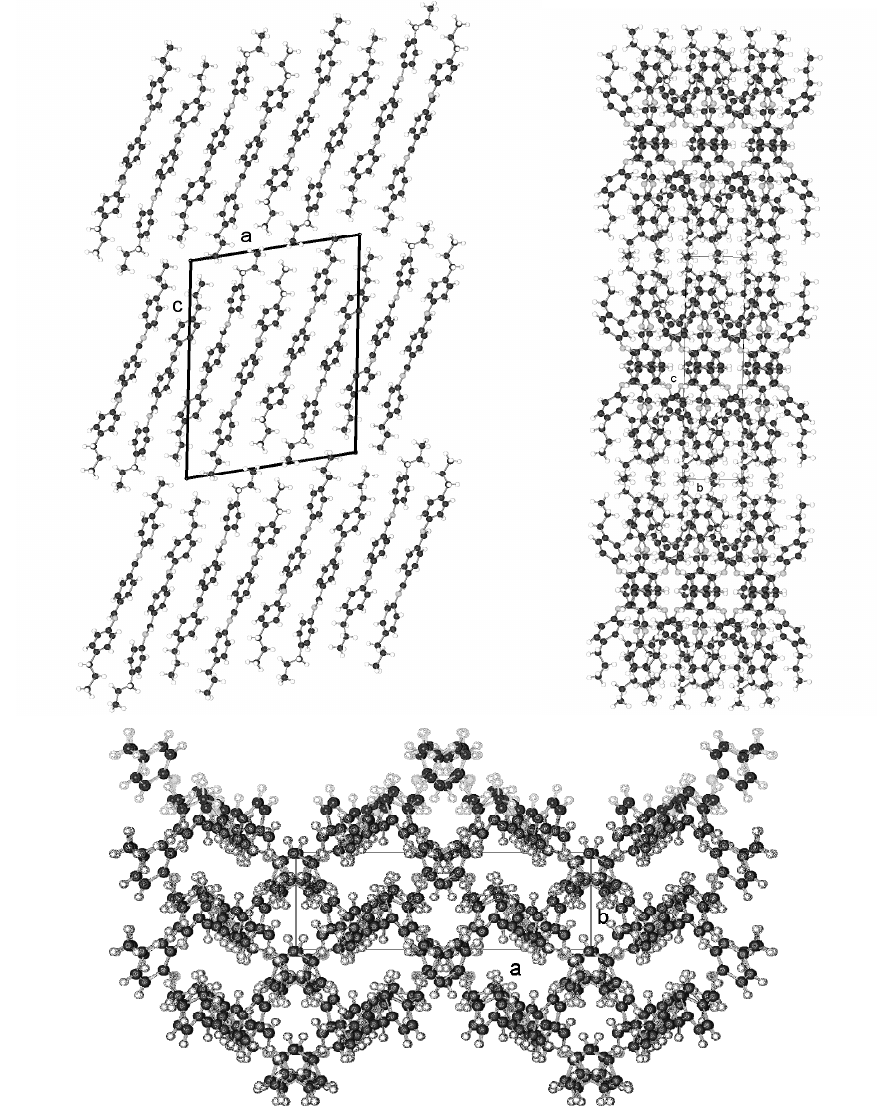
Figure 28. Representation of the packing arrangement of TBAA-3 in three projections on the a,c-plane, on the b,c-plane and on the a,b-plane. Note: a non-parallel arrangement of the molecules as well as the different rotational positions around the molecular